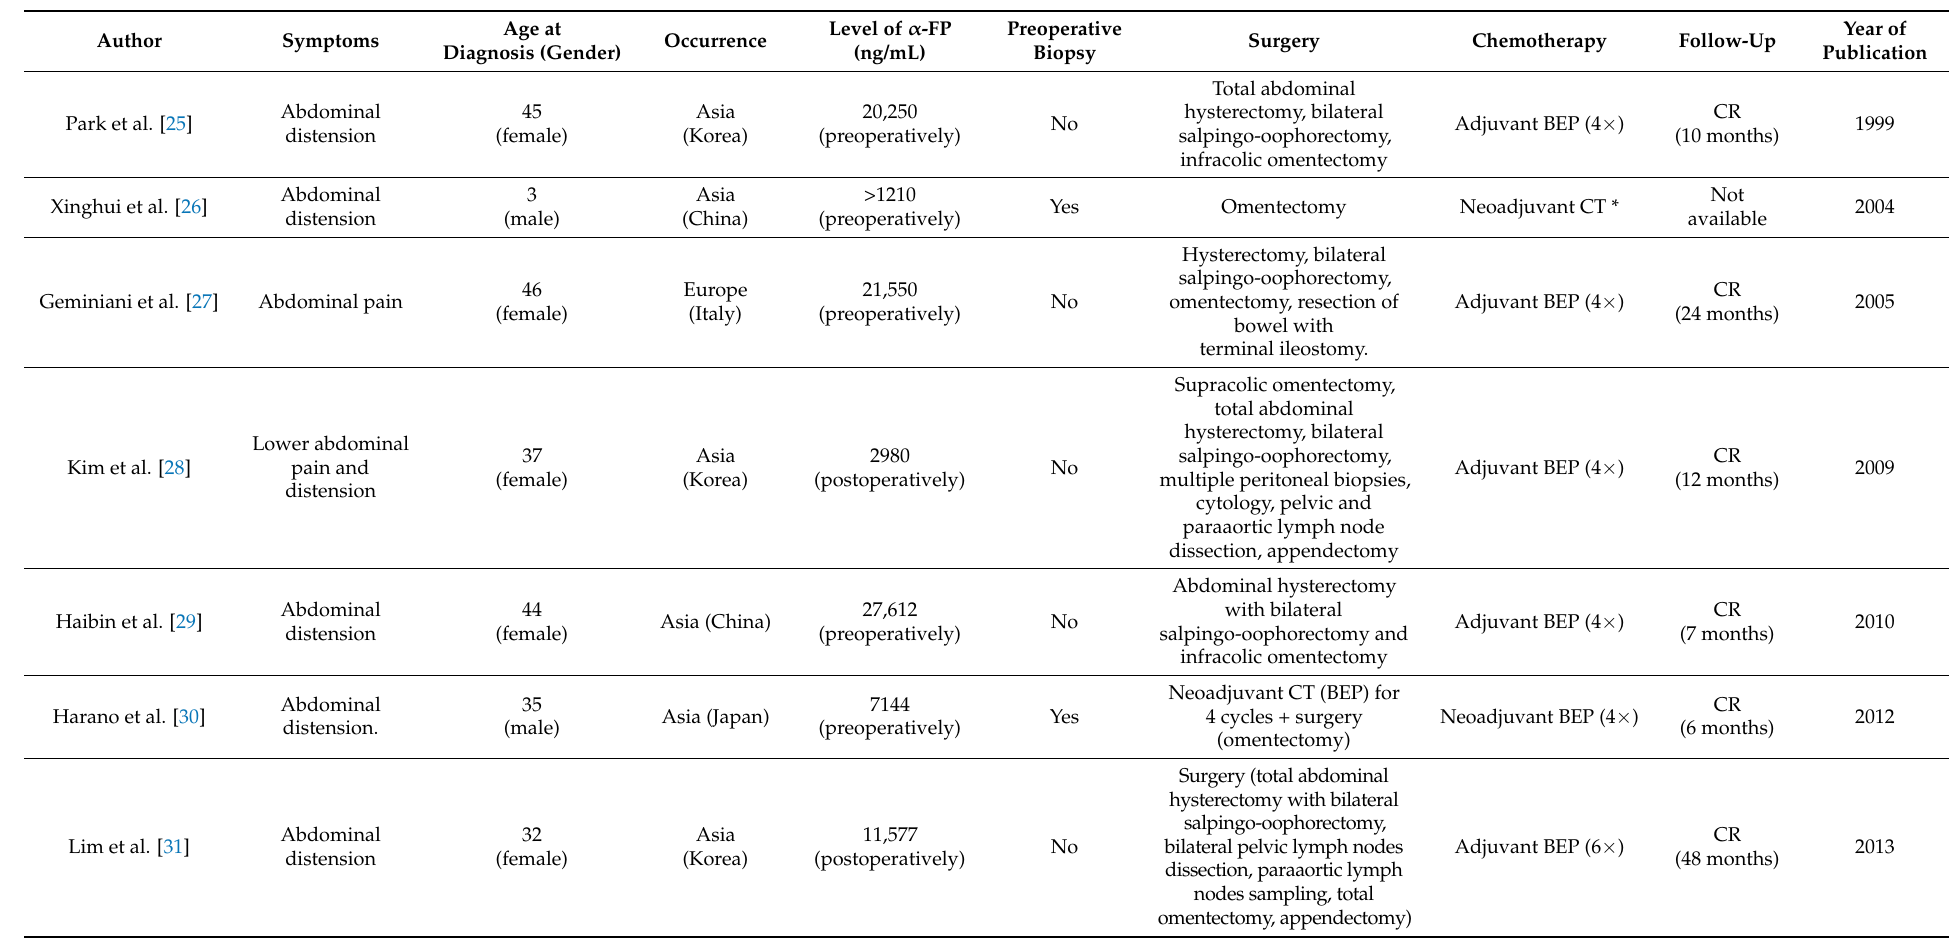
Table 1. Review of primary yolk sac tumors of the omentum. Abbreviations: CT, chemotherapy; BEP, bleomycin, etoposide, and cisplatin; CR, complete